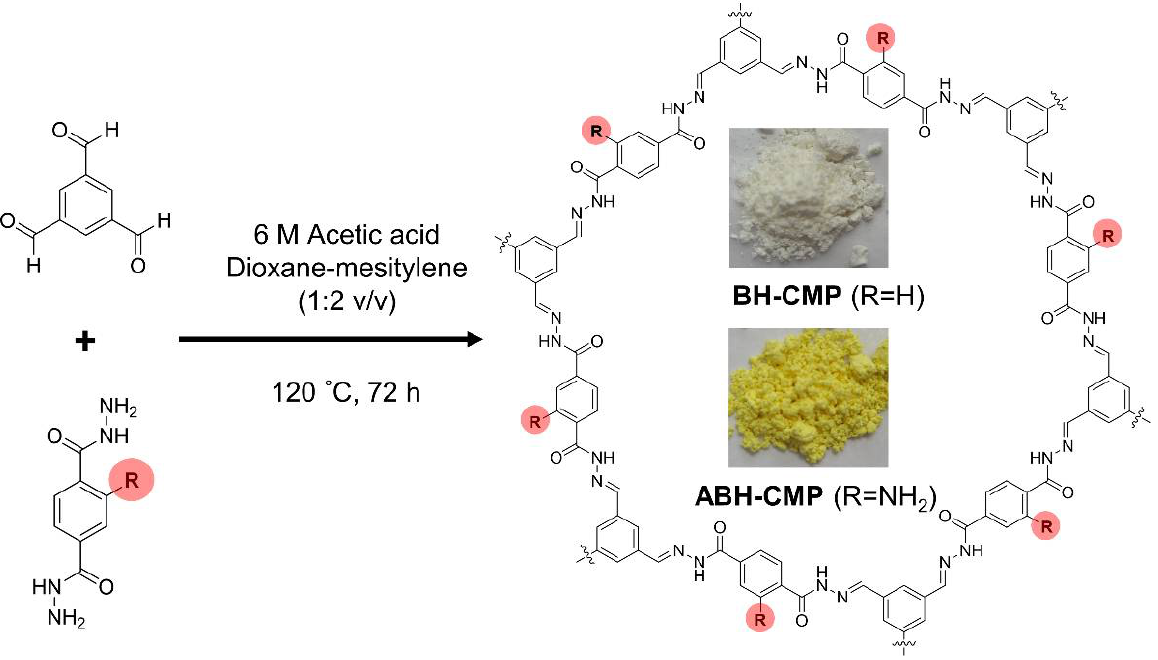
Scheme 1. Synthesis of acylhydrazone-based fluorescent conjugated microporous polymers (CMPs) via acetic acid-catalyzed hydrazone formation